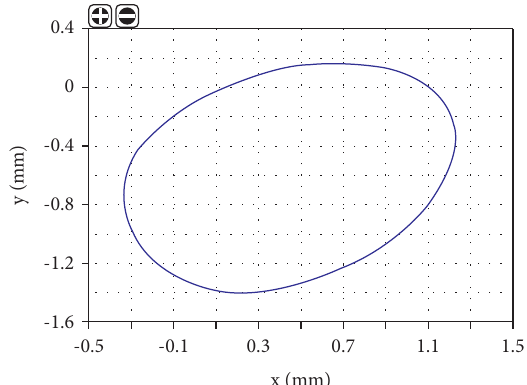
Figure 19: Test axis trajectory.